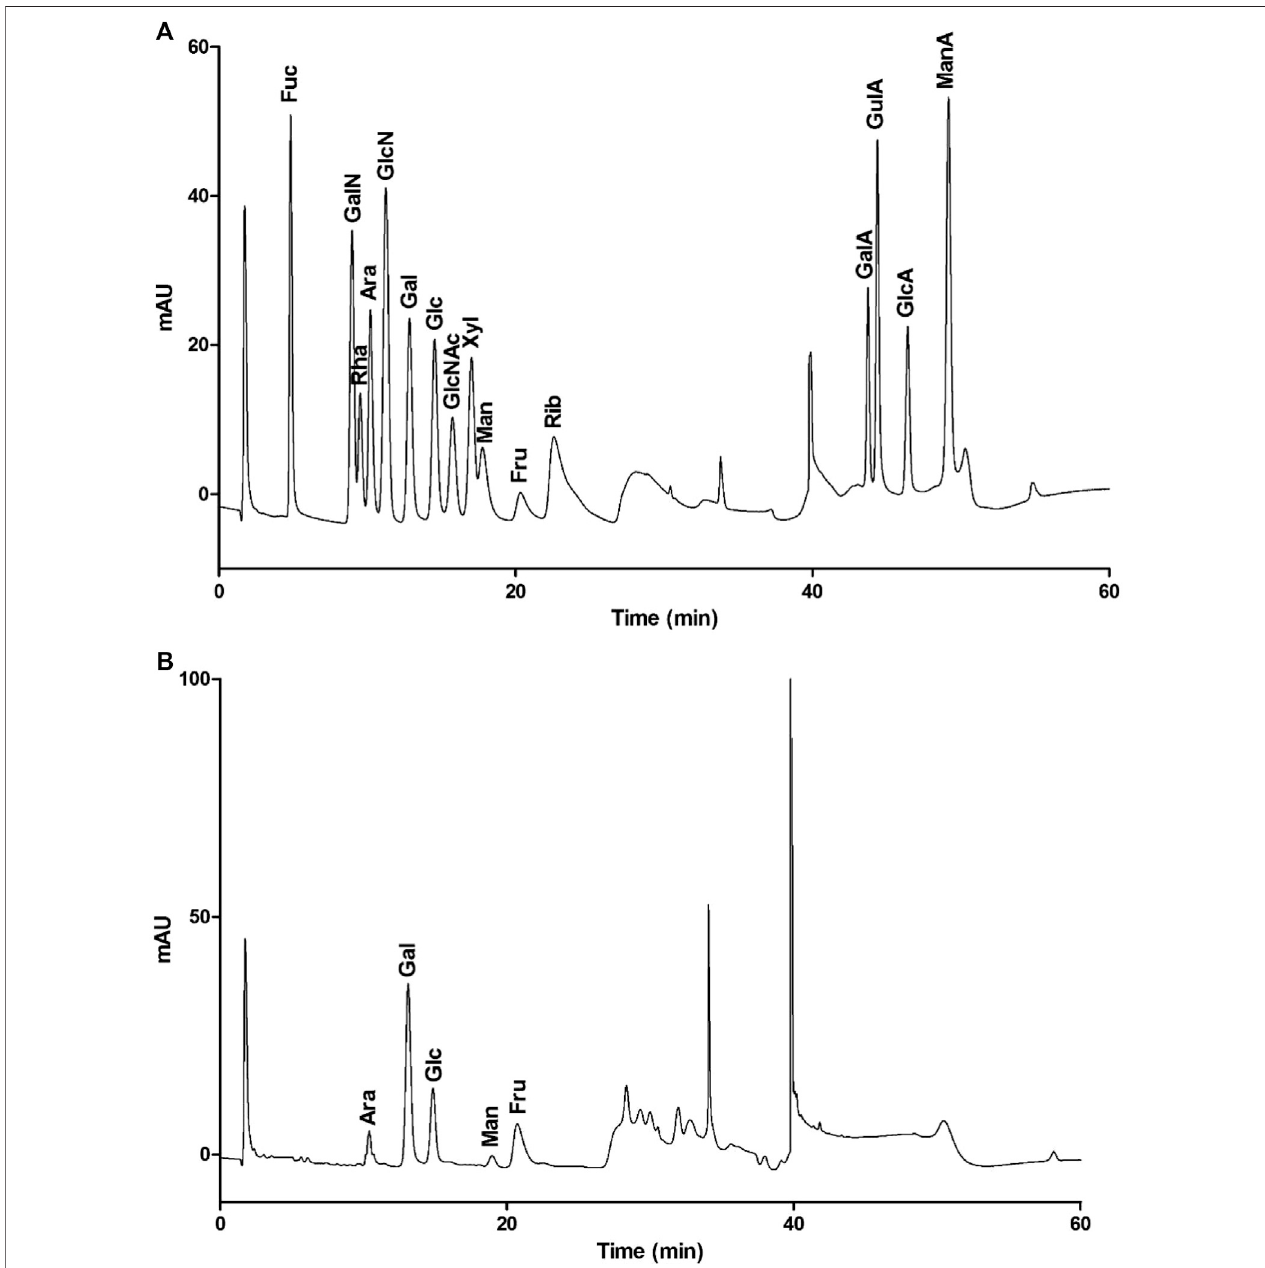
FIGURE 2 | Monosaccharide composition of mixed monosaccharide standards (A) and LHPW (B) .